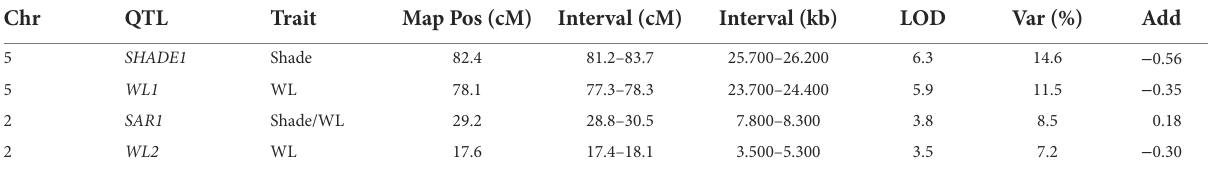
The table indicates the significance of the QTL ( α = 0.10), the chromosome number, trait, map position (cM), 2-LOD interval in physical distance (bp), LOD, % variability explained, and additive effects (the positive and negative signs indicate Col-0 alleles and Pat alleles increase the average response of the trait, respectively). The number of QTL is arbitrary following the relevance of the LOD